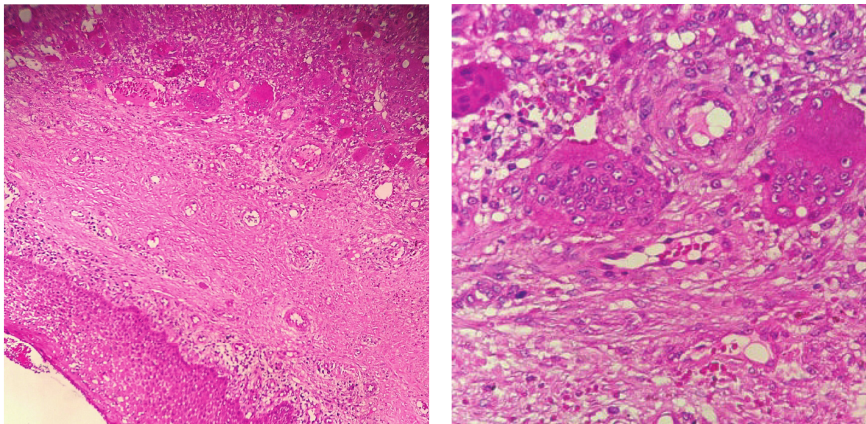
Figure 4: Histopathologic section: hyperplastic granulation tissue, the presence of acute and chronic inflammatory cells, capillaries, and proliferation of multinucleated giant cells within haemorrhagic background showing histological appearance of the PGCG lesion (H&E stain 10x and